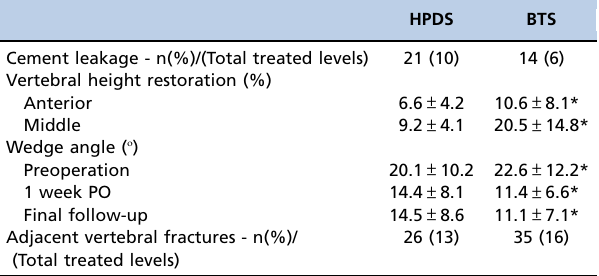
Figure 6 - Scores of VAS (A), RDQ (B), EQ-5D(C), SF-36 PCS (D), SF-36 MCS (E) and ODI (F) with respect to time and intervention group (* p o 0.05). Table 4 - Radiological